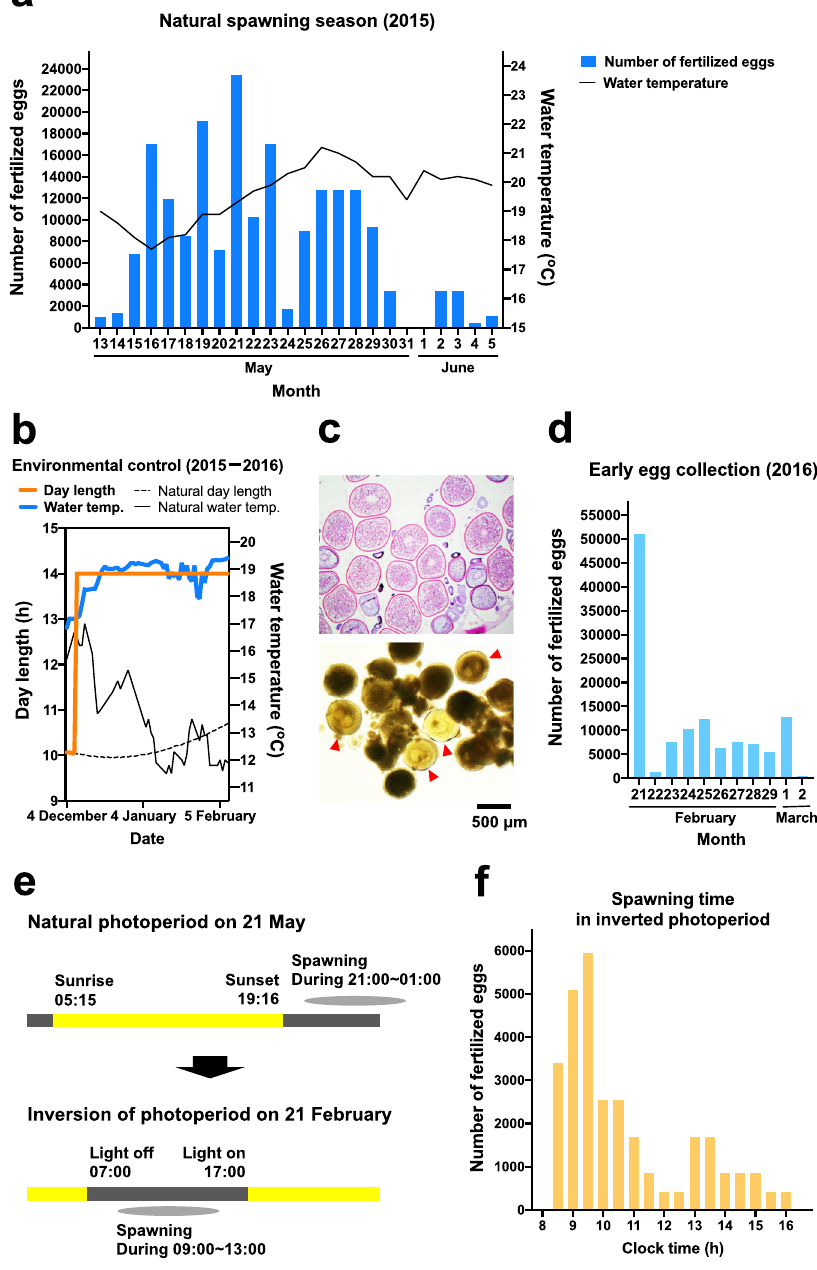
Figure 1. Collection system for fertilized eggs of chub mackerel. ( a ) Results of fertilized egg collection during the natural spawning season of 2015. The blue column shows the number of fertilized eggs collected each day. The bar graph shows the fluctuation of sea water temperature during the period. ( b ) Environmental conditions for artificial maturation. ( c ) Ovarian section of females artificially matured by environmental control (top) and in-vitro bioassay results with human chorionic gonadotropin addition (bottom). Ovarian samples were fixed in Bouin’s solution overnight, dehydrated in a series of ethanol solutions (up to 100%), embedded in paraffin, sectioned at 6 μm using an HM 355S microtome (Thermo Fisher Scientific, Waltham, MA, USA), stained with hematoxylin, and counterstained with eosin. The shredded ovary pieces were transferred to L15 medium (Thermo Fisher Scientific) containing 100 IU of human chorionic gonadotropin (ASKA Pharmaceutical, Tokyo, Japan) and cultured at 18.5 °C for 24 h. Red arrows indicate eggs with germinal vesicle breakdown. ( d ) The number of fertilized eggs collected when spawning was induced in the winter of 2016. Early egg collection was performed by adjusting the environment. ( e ) Spawning time of chub mackerel under natural (upper bar) or artificially reversed day-night photoperiod (lower bar). Black and yellow bars represent night and day times, respectively. ( f ) Time at which fertilized egg was obtained, with day and night of the spawning tank